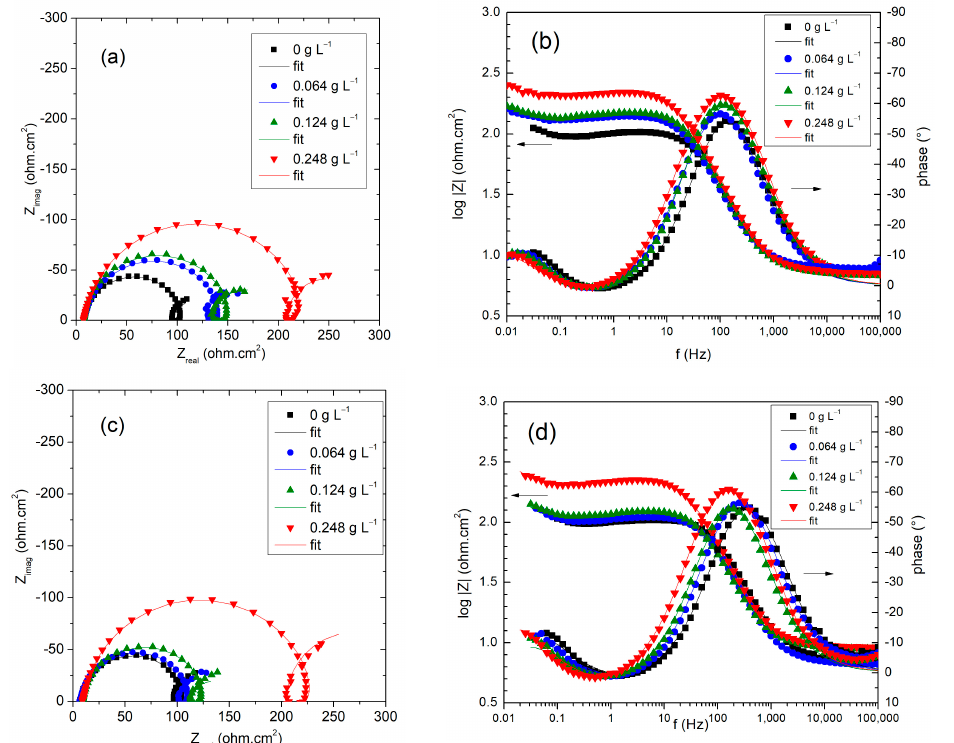
Figure 5. Nyquist and Bode representations of experimental data and fit results of electrode impedance recorded for the system Al/0.1 M HCl in the absence and in the presence of different concentrations of the inhibitor at 308 K ( a , b ), and 323 K ( c , d